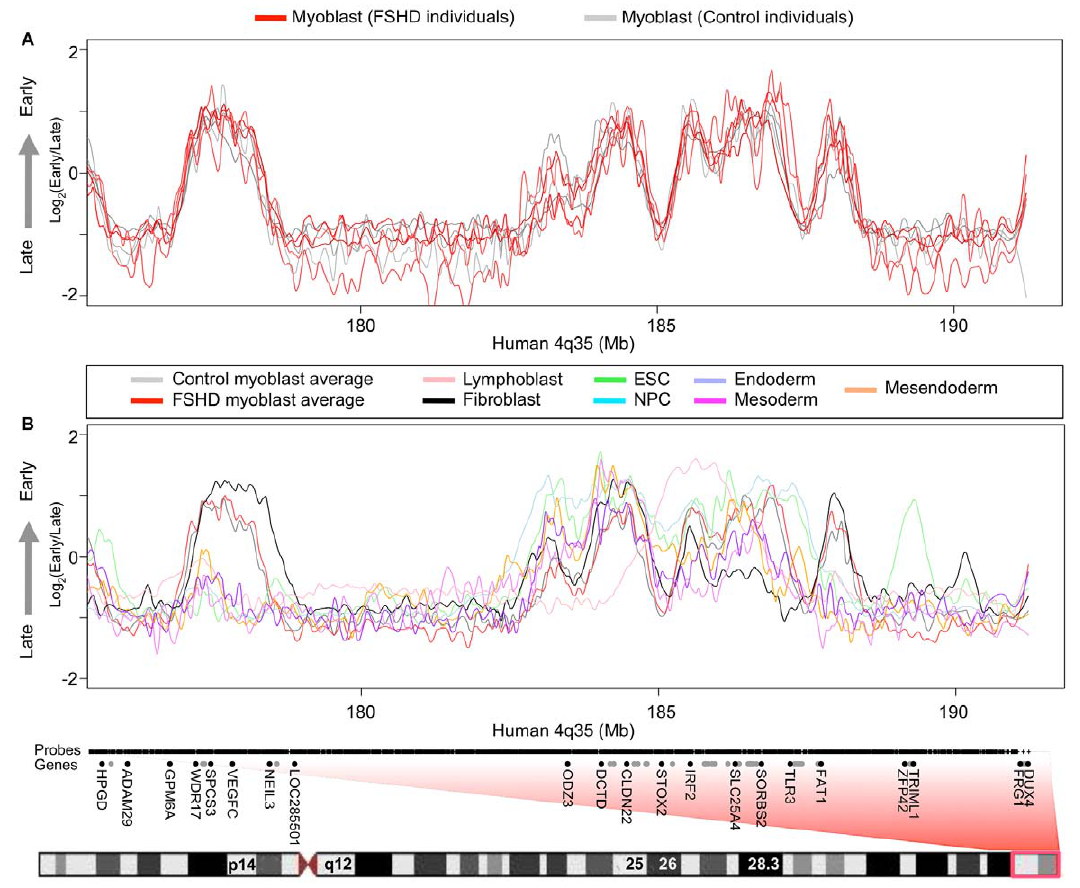
Figure 3. D4Z4 contraction and FSHD disease background do not affect 4q35 replication timing. (A) Primary human myoblast replication timing profiles are shown for 3 control (gray) individuals and 4 FSHD (red) patients across the proximal region to 4q35. One FSHD dataset (FM7) had a low signal to noise ratio and deviates somewhat from other datasets, but was still included for comparison. (B) Replication timing profiles for many different human cell types are shown across the proximal region to 4q35. Boxed in red is the region of human chromosome 4 corresponding to 4q35. Microarray probe positions are indicated along the X-axis by short black vertical lines. Genes are indicated by black dots, for those whose name is given, or gray dots, for those with too high a density to add a label. DUX4 transcripts derived from 4q35.2 D4Z4 map between hg18 chromosome 4 coordinates 191,229,361 and 191,247,457 (UCSC Genome Browser, http://genome.ucsc.edu/).